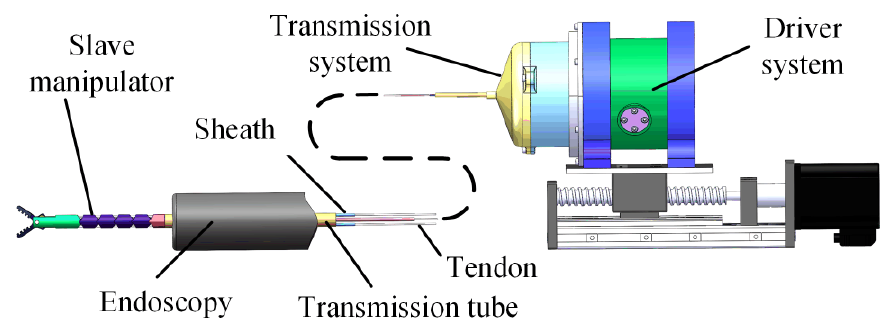
Figure 1. Robotic